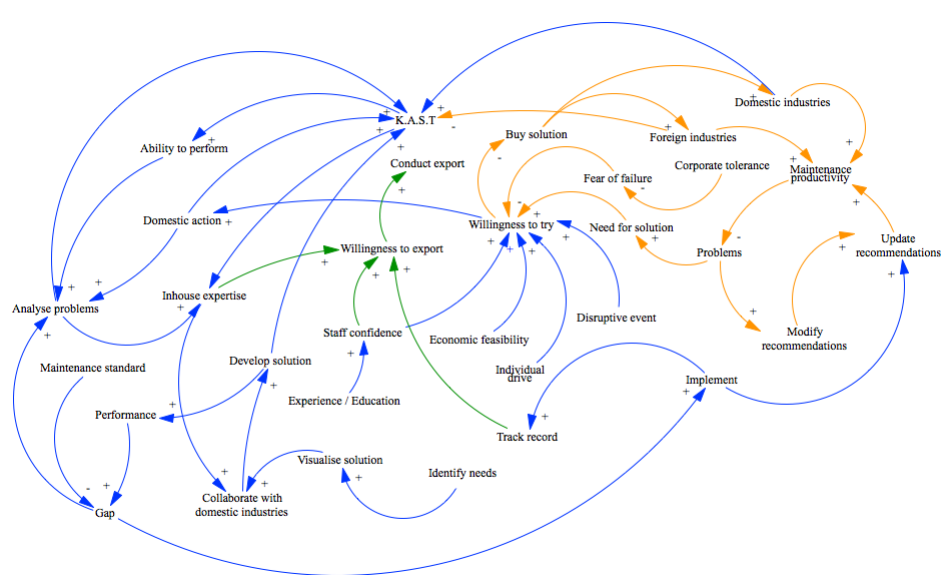
Figure 3. A causal loop diagram describing the behaviour leading to increased domestic